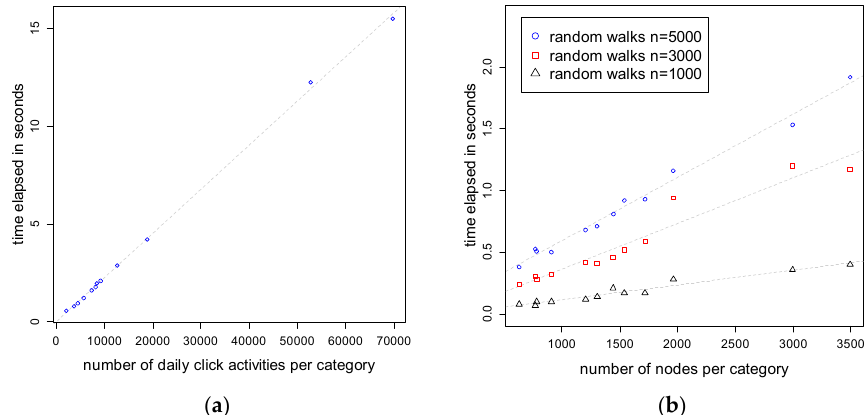
Figure 10. Analysis on computational time of proposed method. ( a ) Time elapsed to construct a unity graph. ( b ) Time elapsed for random walks.